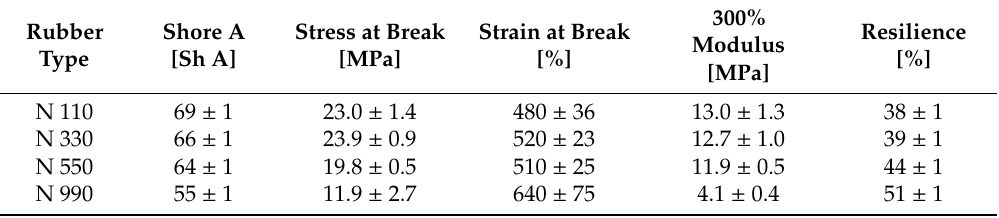
Table 3. Mechanical properties of the rubber